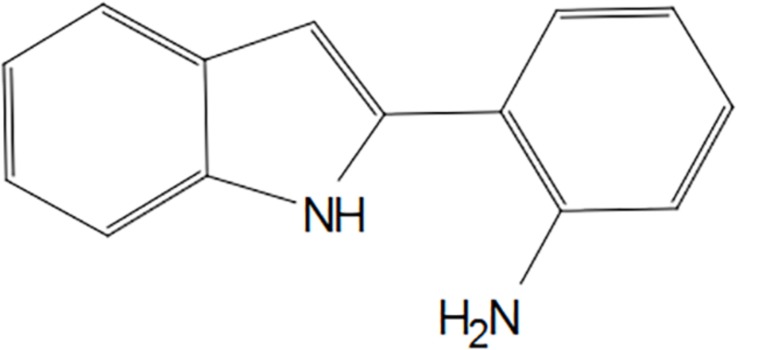
2D structure of RP2.